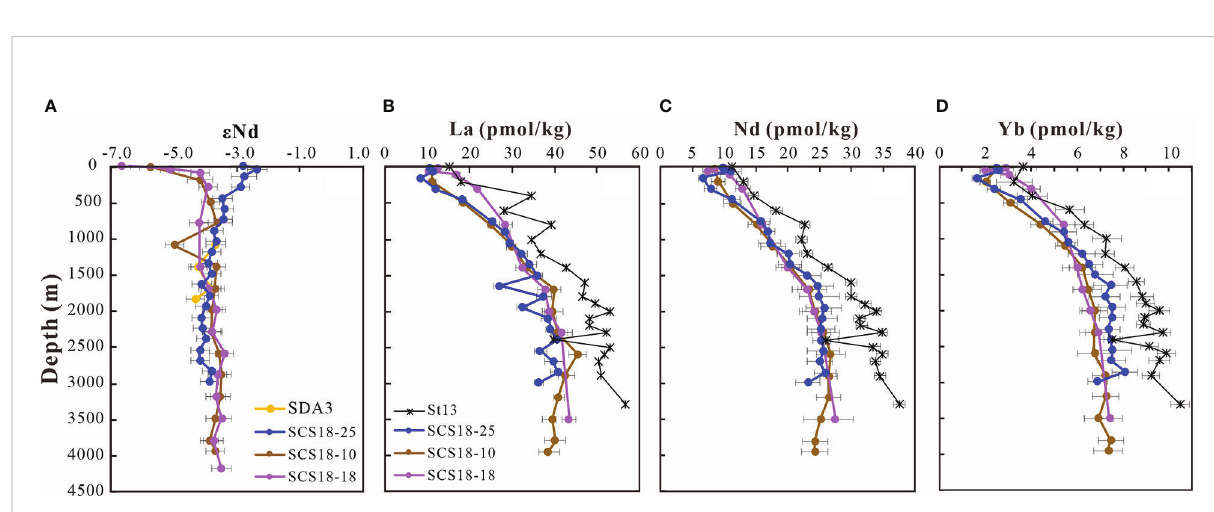
FIGURE 3 Vertical pro fi les of dissolved ϵ Nd (A) and dissolved concentrations of La (B) , Nd (C) , and Yb (D) reported in this study and by Wu et al. (2015;